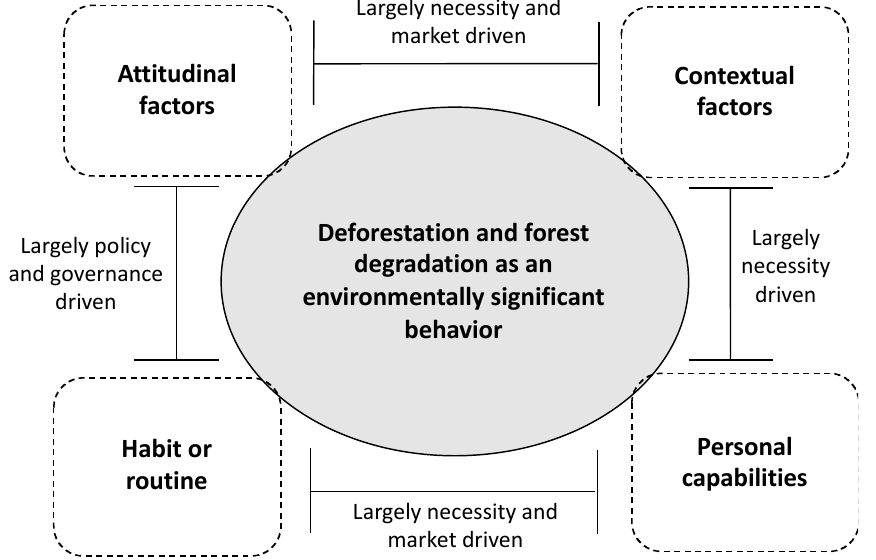
Figure 1. Conceptual framing of the aspects of deforestation and forest degradation (D&D) as an environmental behavior.